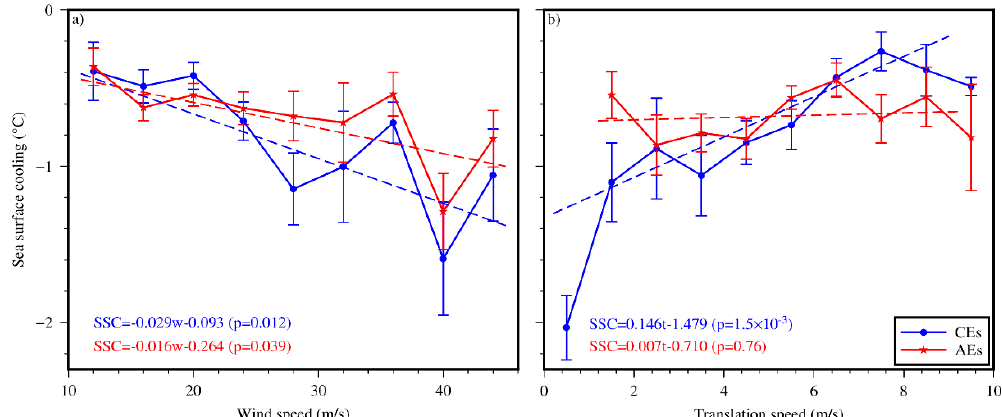
Figure 7. Dependence of typhoon-induced SSC on ( a ) wind speed and ( b ) translation speed of typhoons for co-occurrence of eddies and typhoons. The typhoon-induced SSC in eddies was divided into 14 bins in terms of the corresponding wind speeds between 10 and 50 m/s and translation speeds between 0 and 10 m/s. The CEs (AEs) are shown in the blue (red) curves. Their linear relationships are illustrated and labeled for each panel with the p-value. The vertical bars represent the standard errors of SSC within each bin.